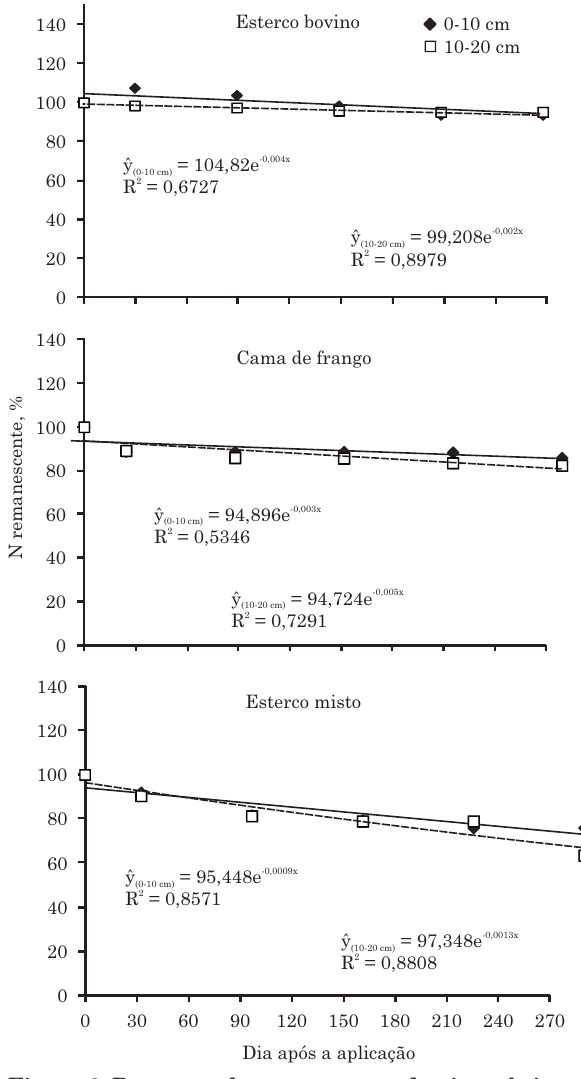
Figura 3. Percentual remanescente de nitrogênio em amostras de esterco bovino, cama de frango e esterco misto, nas camadas de 0-10 e 10-20 cm, em função dos períodos de